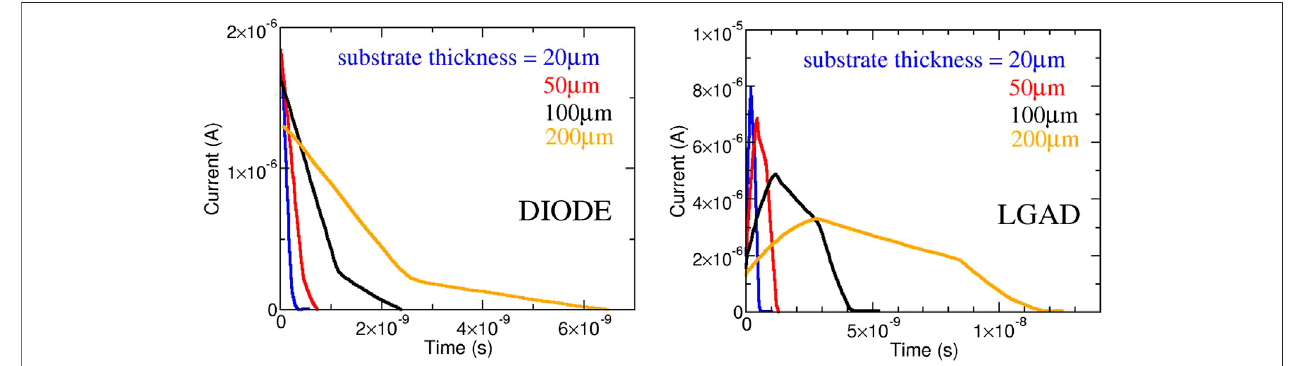
FIGURE 6 | Left (Right), Weight fi eld2 simulations of the signal generated by a mip crossing diodes (LGADs with gain (cid:2) 10) for different substrate thicknesses, as read-out by an in fi nite bandwidth electronics. V (cid:2) 200